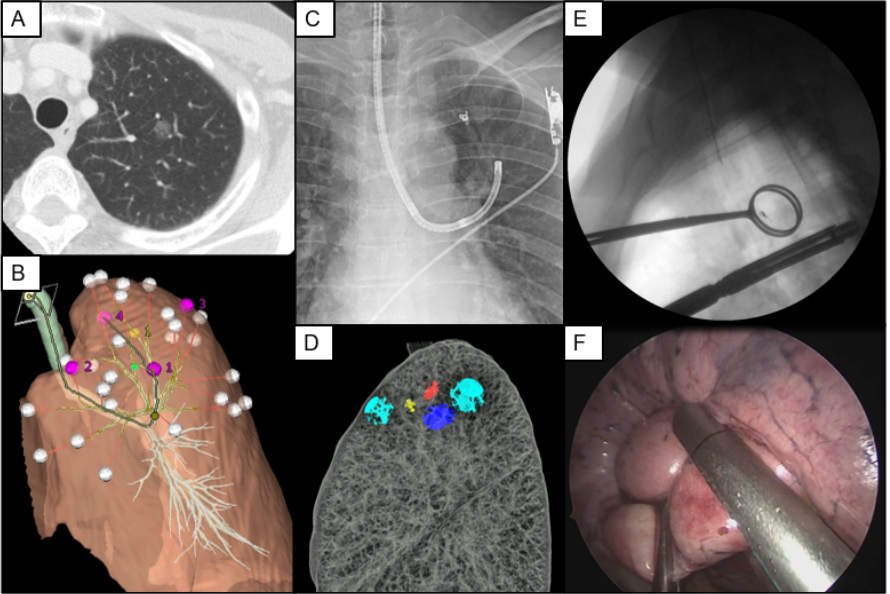
Figure 4. Steps of virtual-assisted lung mapping 2.0. ( A ) Virtual-assisted lung mapping (VAL-MAP) 2.0 is designed to be used for targets which are barely palpable and require a deep resection margin. ( B ) VAL-MAP 2.0 is designed using three-dimensional reconstruction of computed tomography (CT) data and virtual bronchoscopic images in the same way as VAL-MAP 1.0. ( C ) Microcoil is placed under fluoroscopic guidance in a bronchus which is central to the target nodule for wedge resection and close to an intersegmental plane for segmentectomy. ( D ) After a post-mapping CT scan is performed, three-dimensional images of actual marks (blue), microcoil (yellow), and tumor (red) are further reconstructed. ( E ) A fluoroscope is used to visualize the microcoil and guide deep resection lines at stapling during surgery. ( F ) The operation is conducted using three-dimensional images and fluoroscopy for guidance. This figure is reprinted from the reference [43].